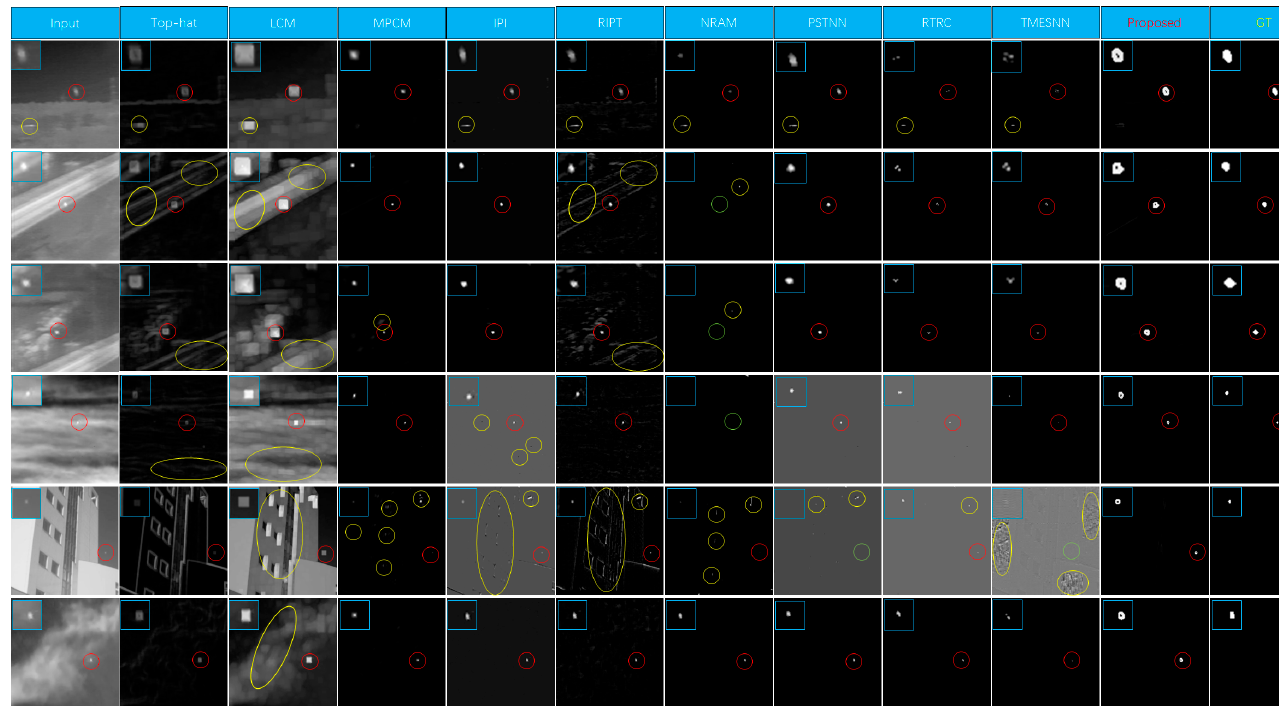
Figure 8. Qualitative results of different methods. Left-top corner of the target area is expanded for better visibility. Red, yellow, and green circles highlight the successfully detected targets, false alarms, and miss detections, respectively. Close to the ground truth (GT), our method provided output with accurate target localization and segmentation with a decreased false alarm rate.